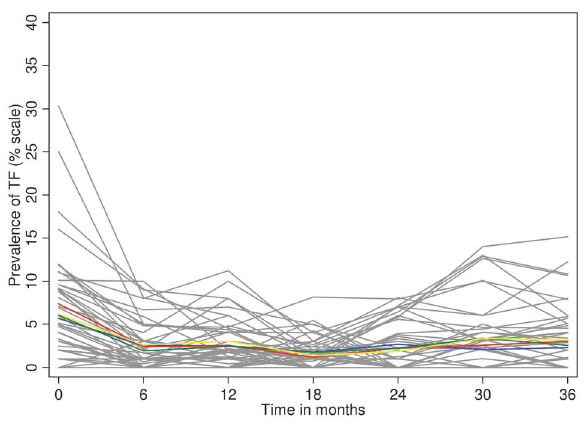
Figure 5. Cluster summarized mean percentage prevalence of Ct infection by study arm (blue: standard, 3 6 red: enhanced,3 6 green: standard, SR yellow: enhanced SR and by individual EA within study arm(grey lines) at each time